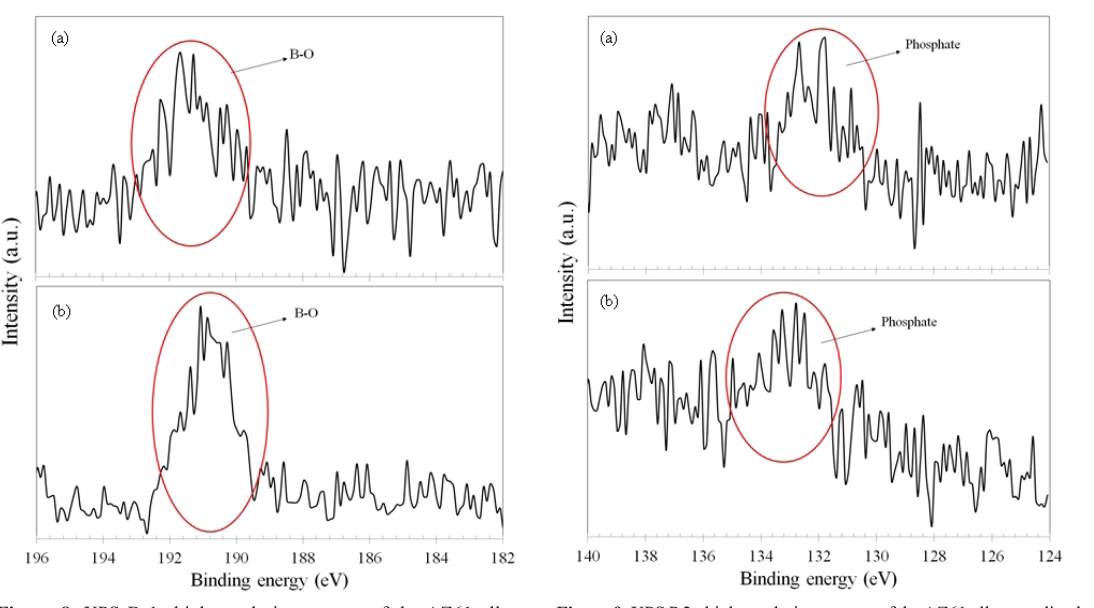
Figure 8. XPS B 1s high resolution spectra of the AZ61 alloy anodized in the borate-containing electrolyte: (a) BO-20; b) BO-30.